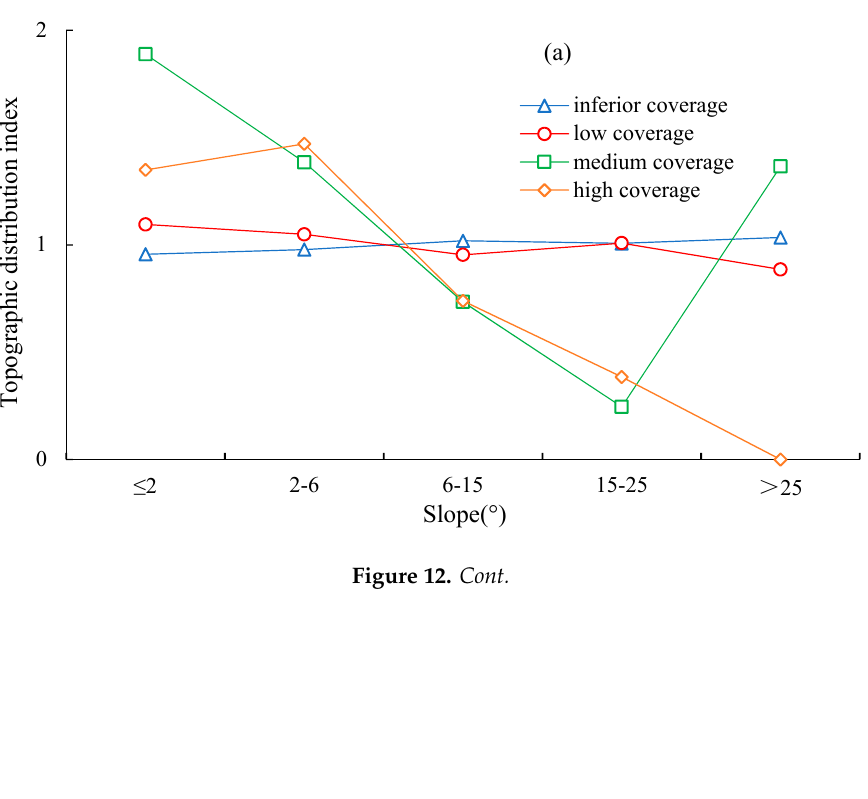
Figure 11. Variations of fractional vegetation coverage and slope in different Pisha sandstone types.